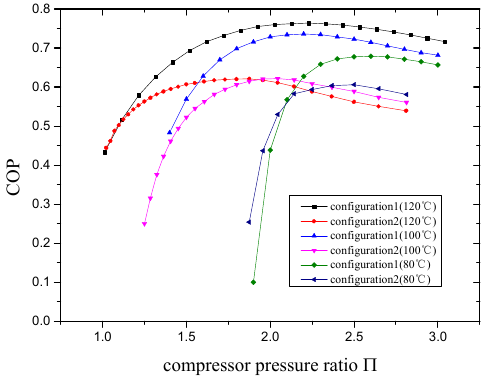
Figure 12. COP versus π at different T GEN for both hybrid cycles.